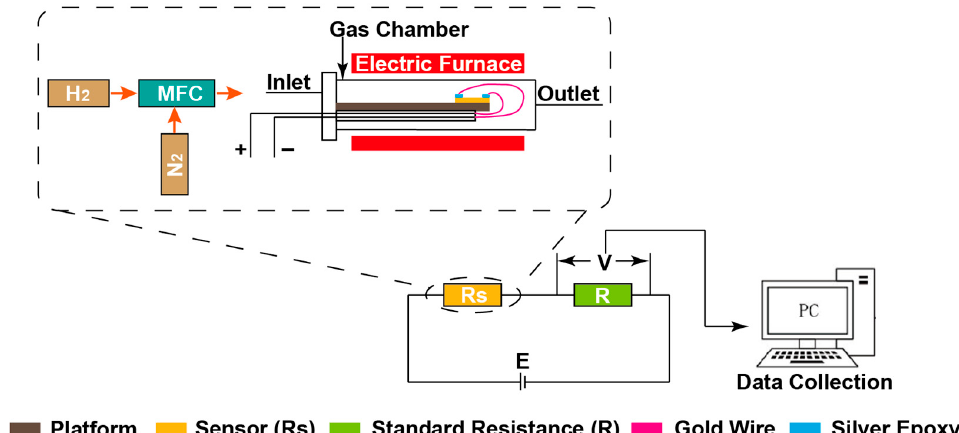
Figure 2. Schematic diagram of a simple H 2 measurement circuit. The inset shows the testing system of the H 2 sensor, including mass flow controller (MFC) and gas chamber.